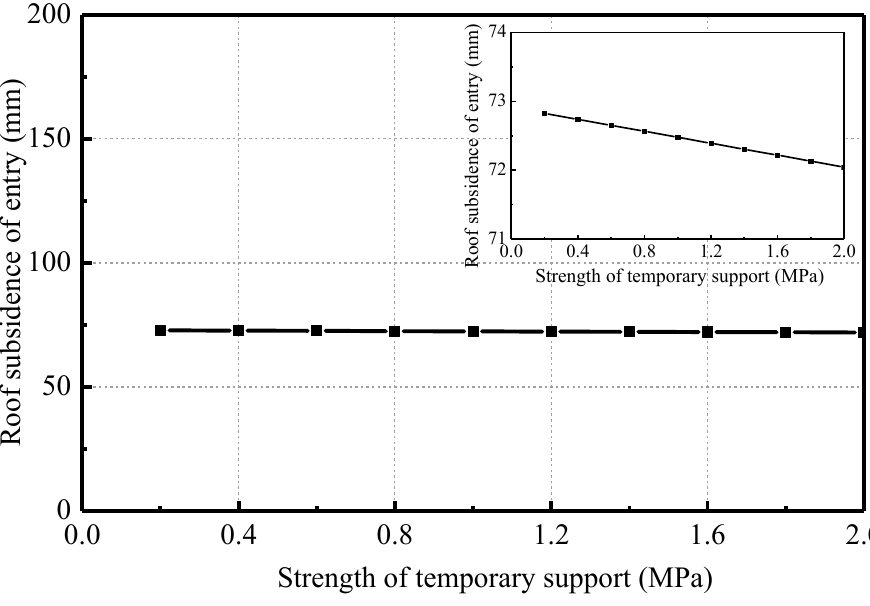
Figure 8. Relationship between roof subsidence and temporary support strength.